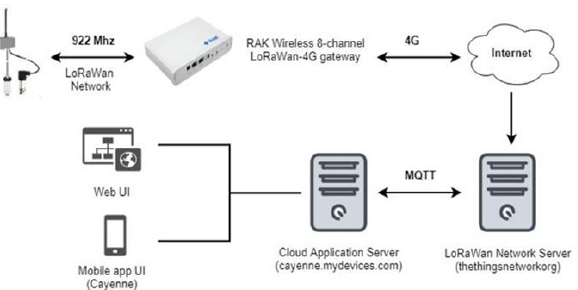
Figure 5. Cloud Computing in Smart Water Monitoring for UTM.